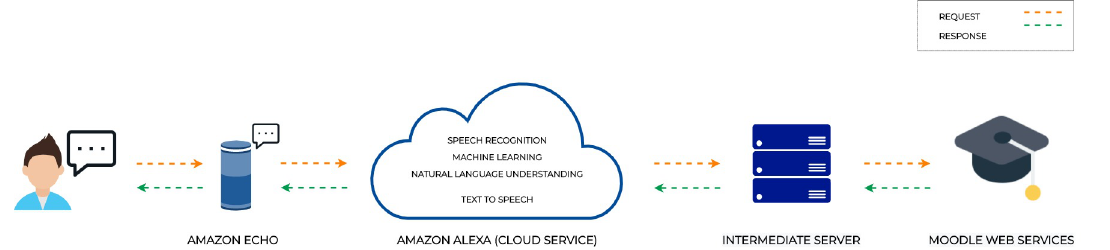
Figure 1. Graphical representation of Kita et al. [32] prototype architecture (Source: own authors’